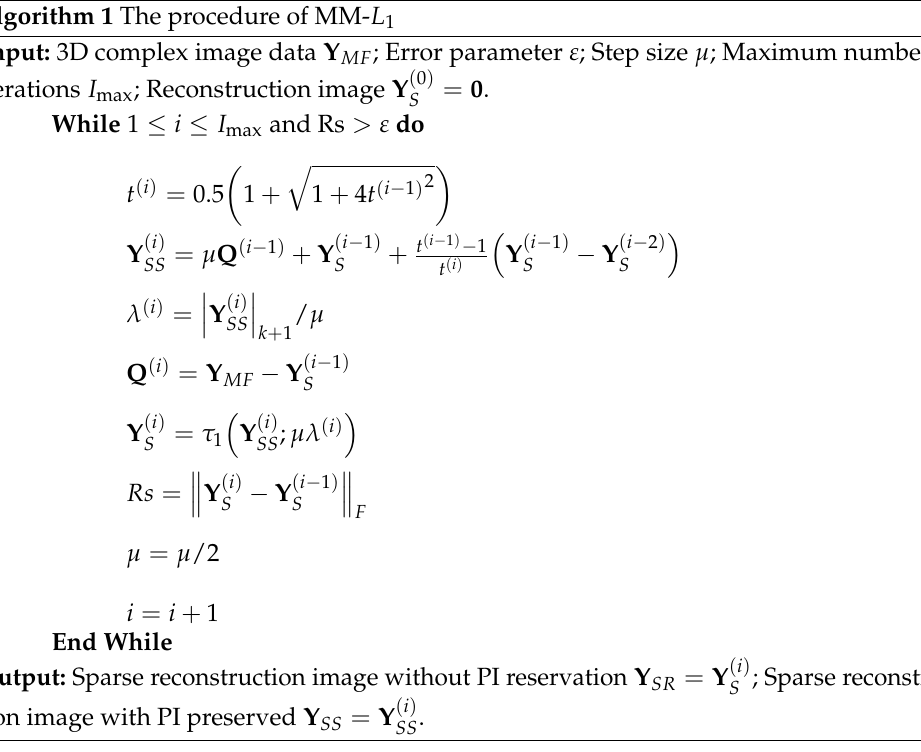
Algorithm 1 The procedure of MM- L